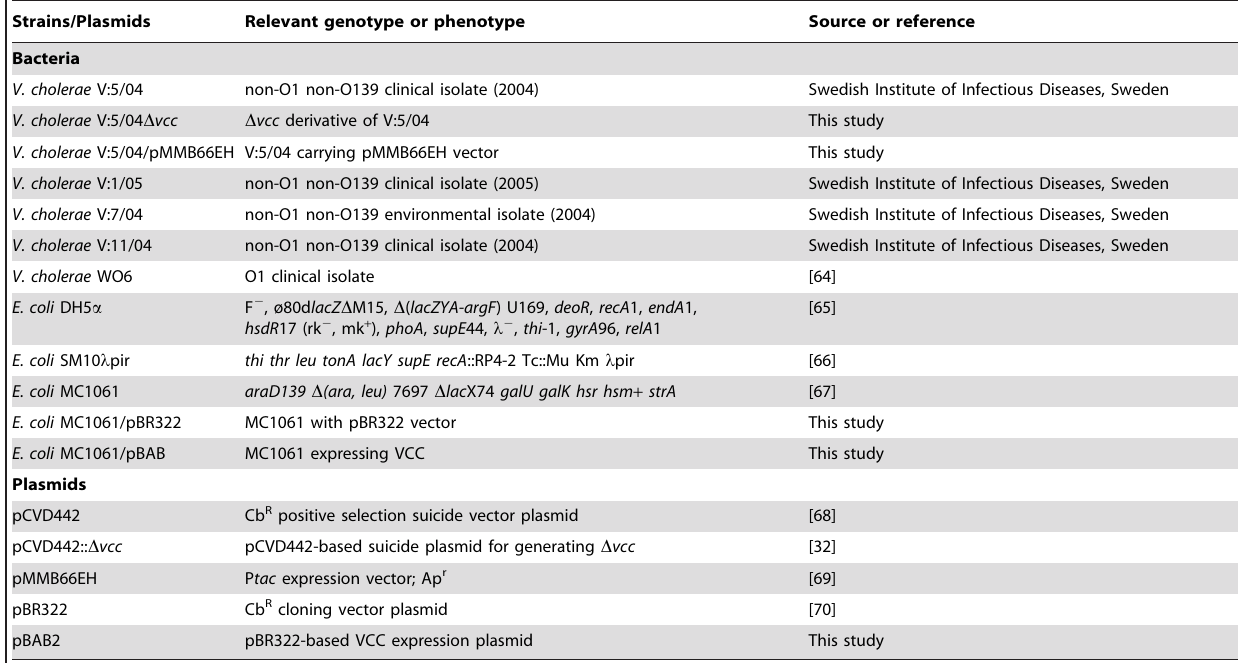
Table 1. Bacterial strains and